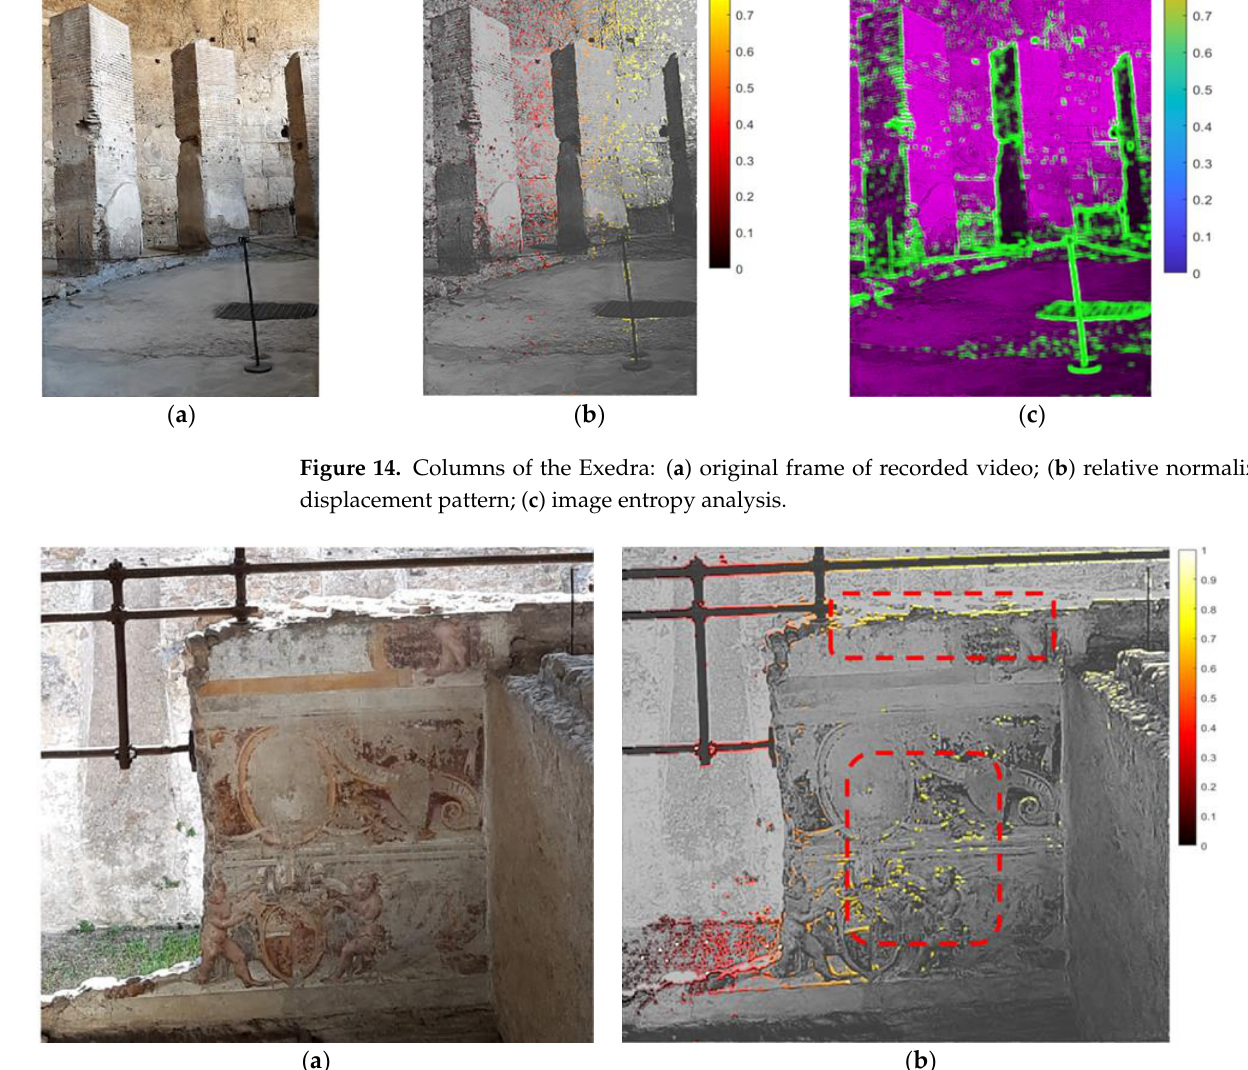
Figure 15. MM analysis of a fresco of the ruined church in the courtyard: ( a ) original frame of recorded video; ( b ) relative normalized displacement pattern.